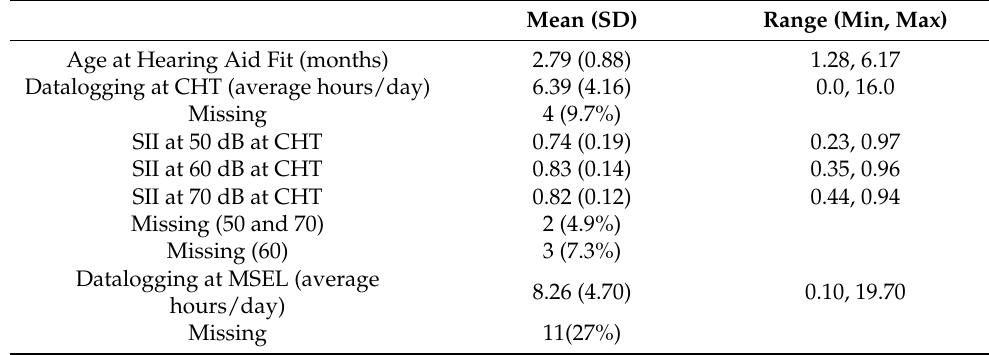
Table 2. Characteristics unique to